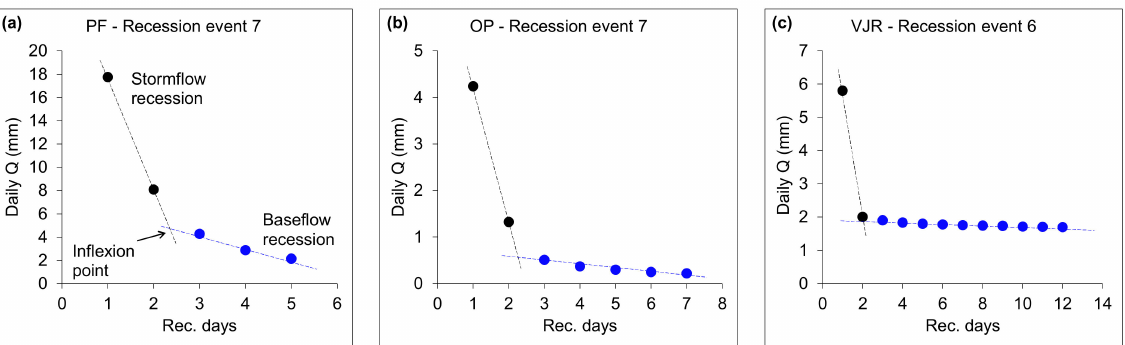
Figure 2. Stormflow recession, inflexion point, and baseflow recession on falling limbs. Examples of the shortest (3 days) baseflow recession event ( a ), the median length (5 days) baseflow recession event ( b ), and the longest (10 days) baseflow recession event ( c